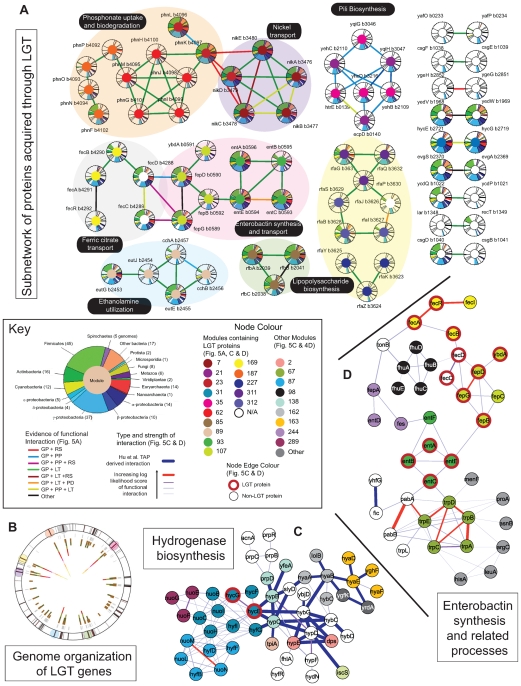
Organization of laterally transferred interactions.A: Organization of LGT-derived proteins within the combined network. Each pie chart indicates a single protein, with the coloured arcs reflecting its phylogenetic profile (see inset key). The colour at the centre of each pie chart indicates module membership. Large coloured ovals grouping proteins define gene neighbourhoods (each gene is within 2000 bp of at least one other gene). Colours of links represent type of supporting evidence (GP = genome proximity; RS = Rosetta stone; PP = phylogenetic profiles; LT = literature curation; PD = pull down). The embedded colour key indicates the breakdown of taxonomic groups used to construct the phylogenetic profiles – numbers indicate the number of genomes associated with each group. B: Organization of LGT genes with the E. coli genome. The outer circle indicates the location of LGT genes. Grey lines indicate LGT genes not identified within our network. Coloured lines extending into the center indicate LGT genes identified within our network, organized into gene neighbourhoods. Coloured circles indicate the relationship between the gene neighbourhoods and their organization within the network shown in A. C: Network organization of proteins involved in hydrogenase biosynthesis. Two proteins associated with hydrogenase 3, hycE and hycG are thought to derive through LGT and are highlighted. Also present in the combined network are proteins associated with: hydrogenase 1 (hyaABDEF); hydrogenase 2 (hybCDFO); hydrogenase 4 (hyfBDFGI); hydrogenase maturation (hypBCDEF and slyD); and NADH∶ubiquinone biosynthesis (nuoBCEFGHILMN). D: Network organization of proteins involved in enterobactin synthesis and related processes. Again proteins thought to derive through LGT and are highlighted. Also shown are components of the tryptophan biosynthetic pathway responsible for production of the chorismate precursor of enterobactin (trpABCDE); and components of two other related iron transport systems – fhuABCDE and fecABCD, which uptake iron via hydroxamate and dicitrate respectively.